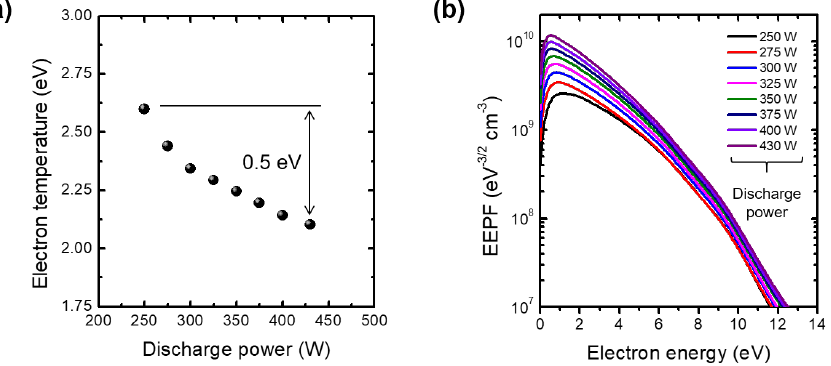
Figure 2. ( a ) Measured electron temperature (T e ) over the discharge power and ( b ) electron energy probability function (EEPF) with various discharge powers at pressure of 206 mTorr. The Lang- muir probe position is 58 mm, which is the center between the dielectric window (Al 2 O 3 ) and the grounded